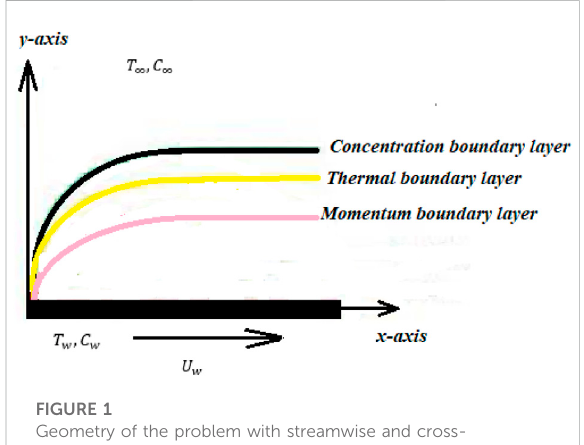
FIGURE 1 Geometry of the problem with streamwise and cross- streamwise